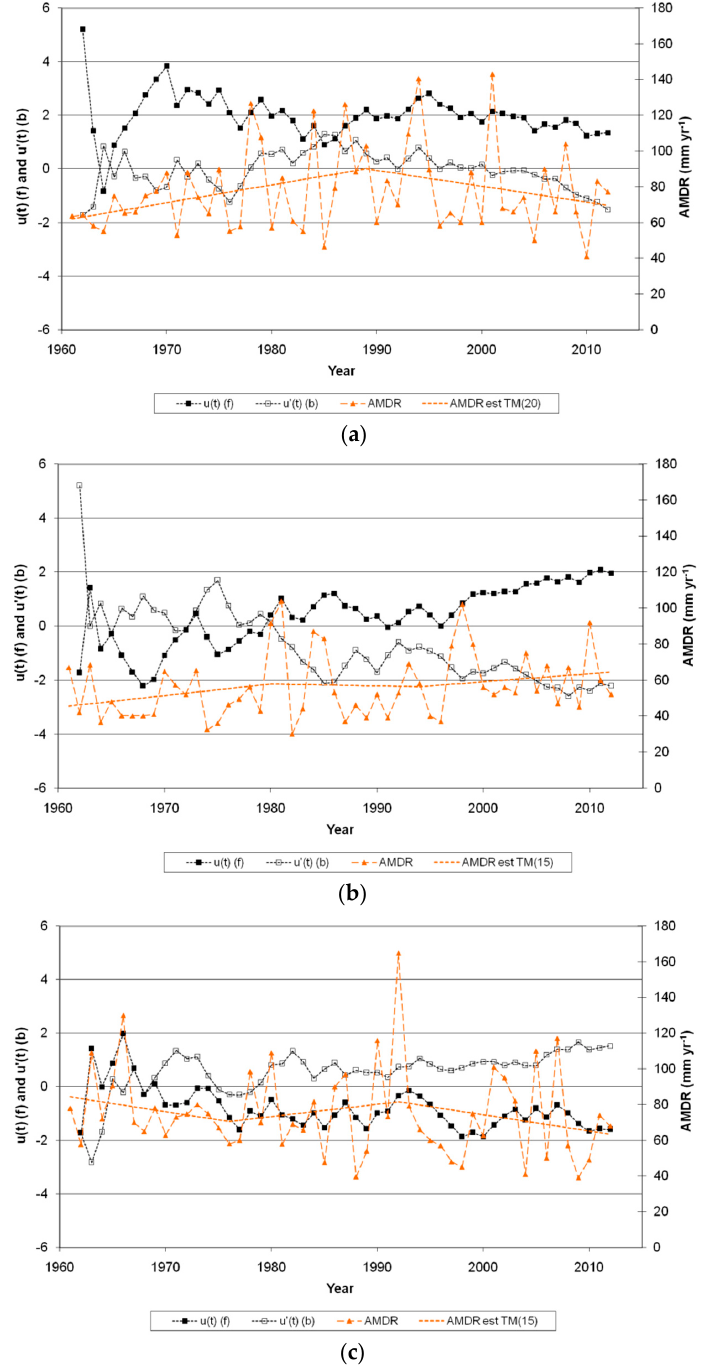
Figure 7. Variation of the annual maximum value of daily rainfall (AMDR) at RC ( a ), VD ( b ), and VM ( c ) between 1960 and 2012, and determination of the breakpoint from Mann–Kendall–Sneyers, where u(t) and u’(t) are the forward (f) and backward (b) test values, respectively, and from Tomé–Miranda (TM), where MINIX = 20 for ( a ) and 15 for ( b ) and ( c ). Similarly to the pluviometric indicator trend change observed in the province of Córdoba, there is also an abrupt change of trend in rainfall in southern Australia [39] and in South Carolina (USA) [9] in the 1960s and 1970s, which may correspond to a more generalized atmospheric phenomenon linked to the multidecadal dynamics of the North Atlantic Oscillation (NAO) and the South Oscillation Index (SOI).